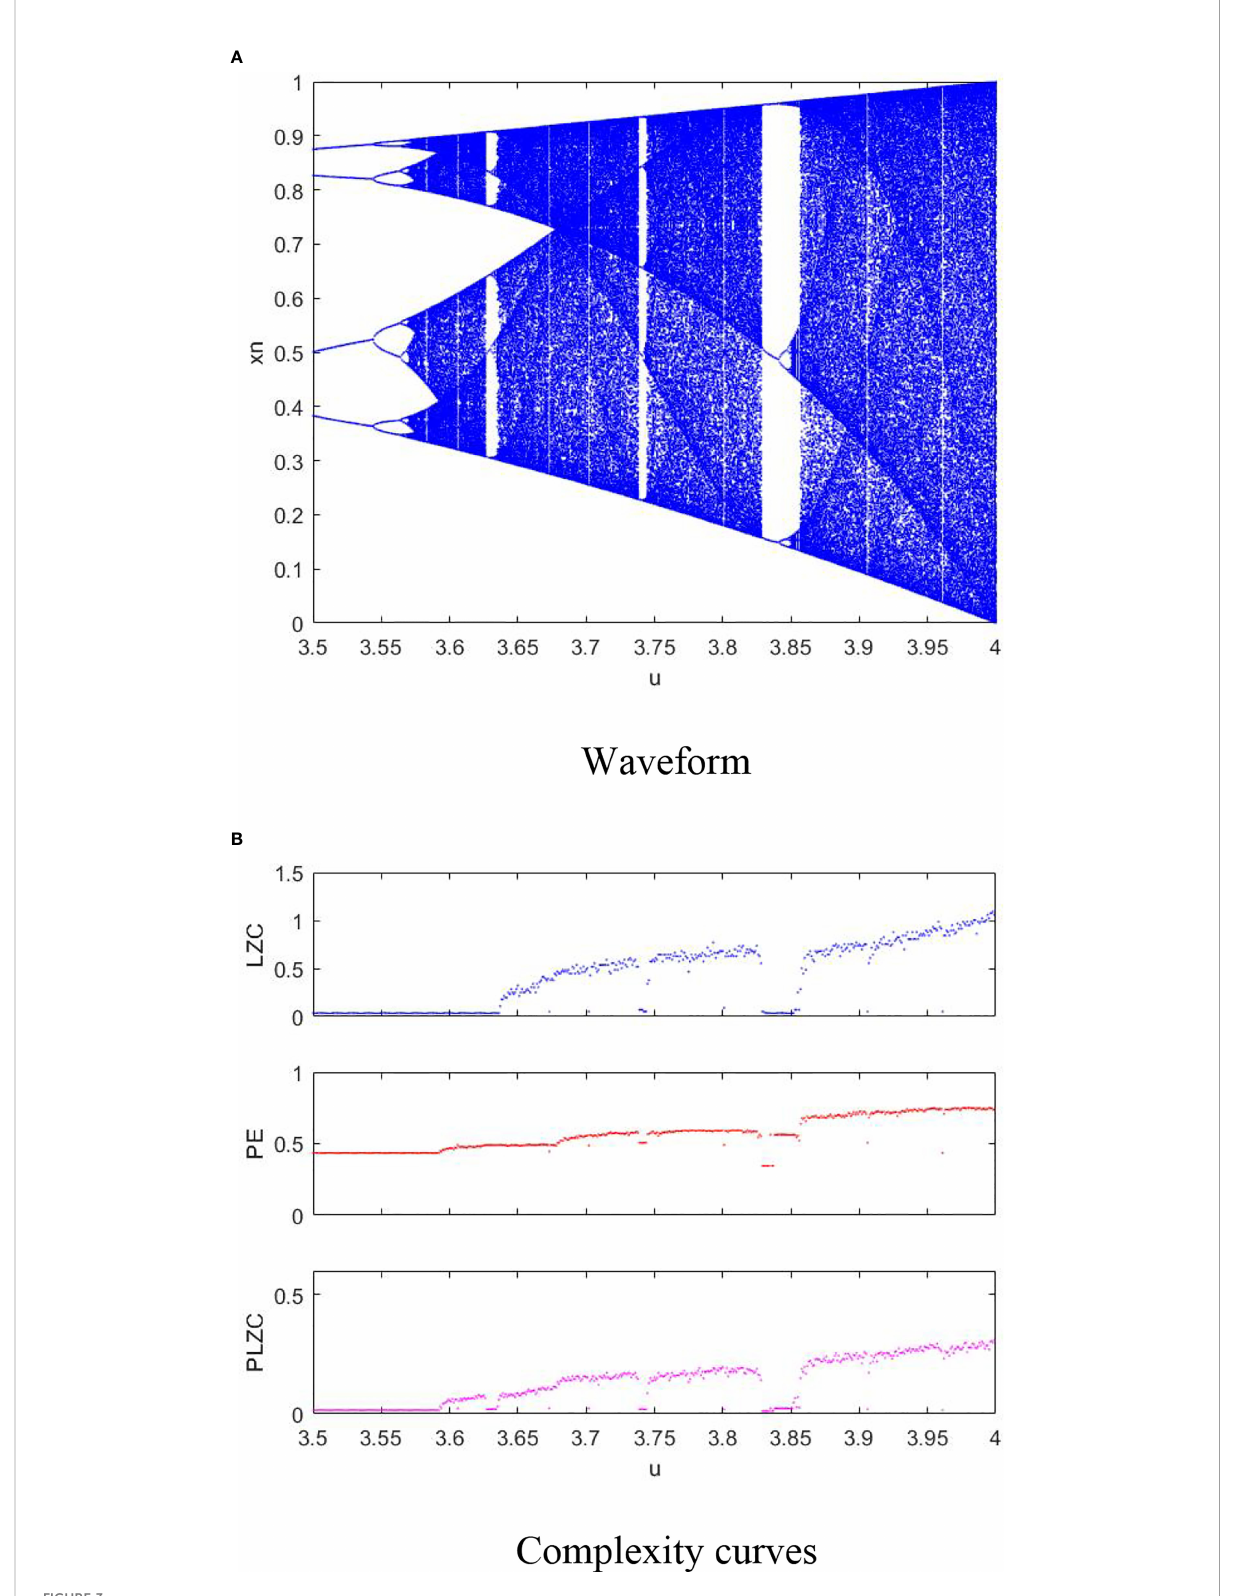
FIGURE 3 Waveform and complexity curves of logistic model: (A) Waveform; (B) Complexity